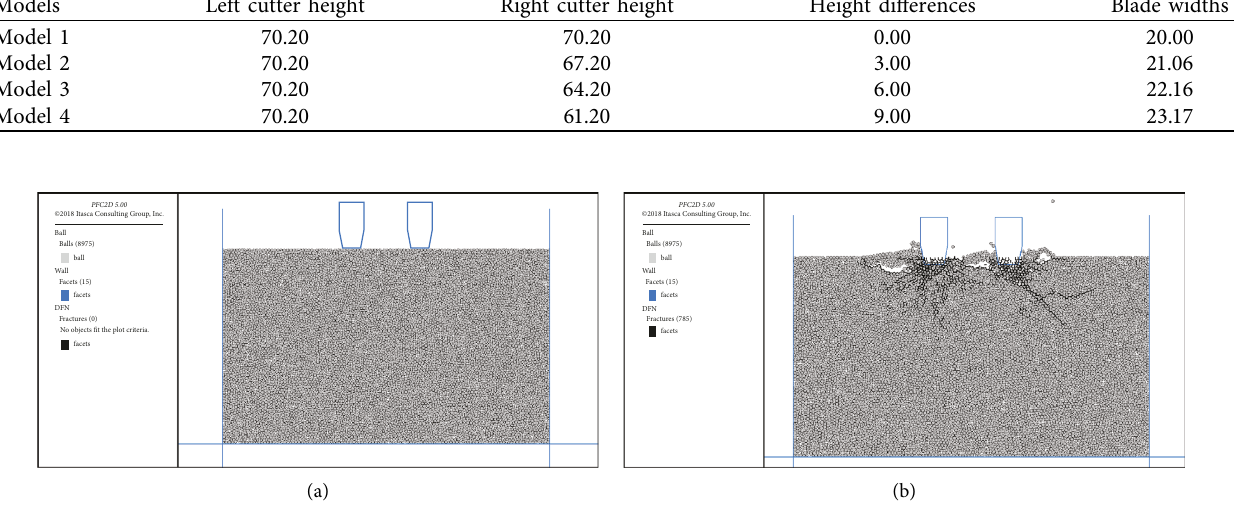
Figure 8: Rock-breaking effect of model 1: (a) before loading; (b) after